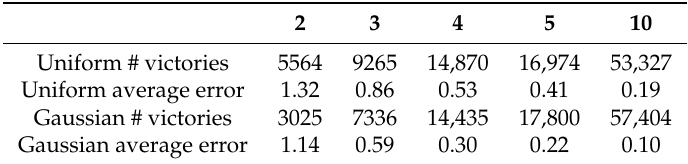
Table 1. Number of times each value of k in {2,3,4,5,10} produces minimal error and average error values, over 100,000 items generated according to both models.